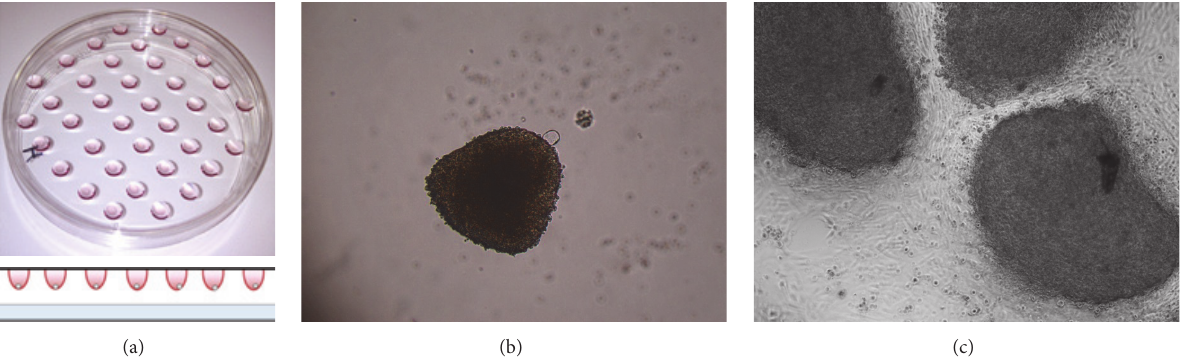
Figure 6: Photograph and schematic diagram of the hanging drop culture model (a). 100x magnification of a HTR8/SVneo spheroid (b) and attachment of HTR8/SVneo spheroids on a 2D St-T1 cell layer (100x magnification) (c).